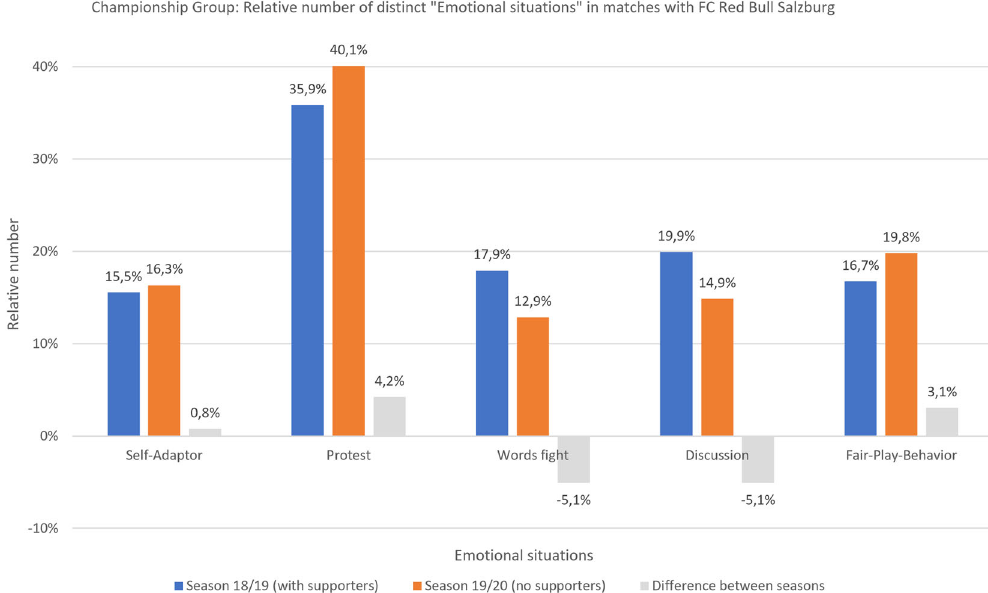
Fig. 3 Relative number of “ Emotional situations ” . Differences in the number of distinct emotional behavior of players, staff, and of fi cials in matches with FC Red Bull Salzburg (RBS) during the championship group phase in both seasons of 2018/19 and 2019/20 relative to the overall number of emotional situations. Video documentation and analysis is based on our developed “ Analysis System for Emotional Behavior in Football ” (ASEB-F) (see above for details). Data shows the number of emotional behaviors “ Self-Adaptor ” , “ Protest ” , and “ Fair-Play-Behavior ” increased in “ ghost games ” , whereas “ Words fi ght ” and “ Discussion ” decreased in “ ghost games ” . This indicates that while players, staff and of fi cials acted predominantly less emotionally in “ ghost games ” , “ less extensive ” behavior like “ Self-Adaptor ” , “ Protest ” , and “ Fair-Play-Behavior ” increased in number and “ more extensive ” behavior like “ Words fi ght ” and “ Discussion ” decreased in duration in “ ghost games ” .